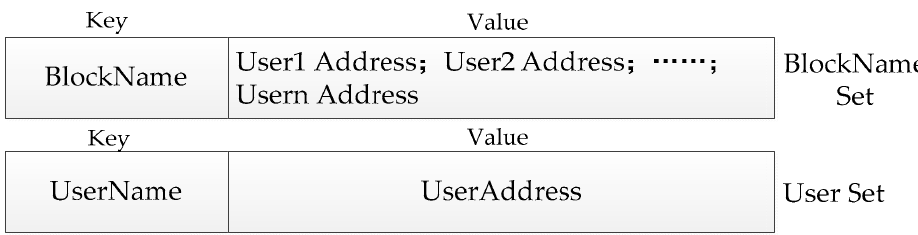
Figure 5. The logical storage structure of “Block Name Set” and “User Set”.